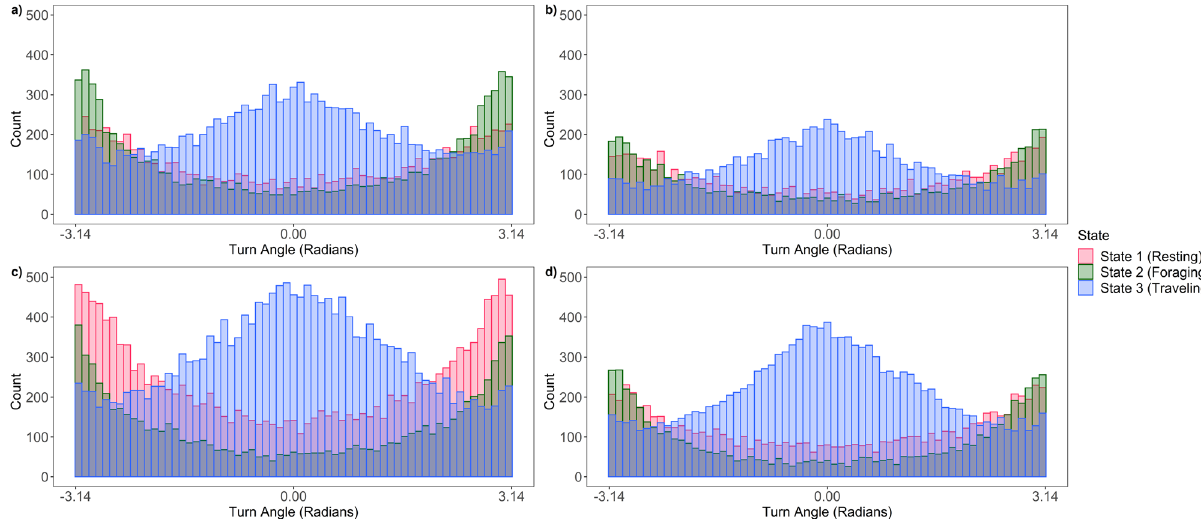
Figure 3. Turn angle parameter distributions from three-state hidden Markov models (HMMs) for wild pigs ( Sus scrofa ) in the Southeast USA by sex and season: ( a ) females in low-forage months (January–April); ( b ) males in low-forage months; ( c ) females in high-forage months (May–December); ( d ) males in high-forage months.